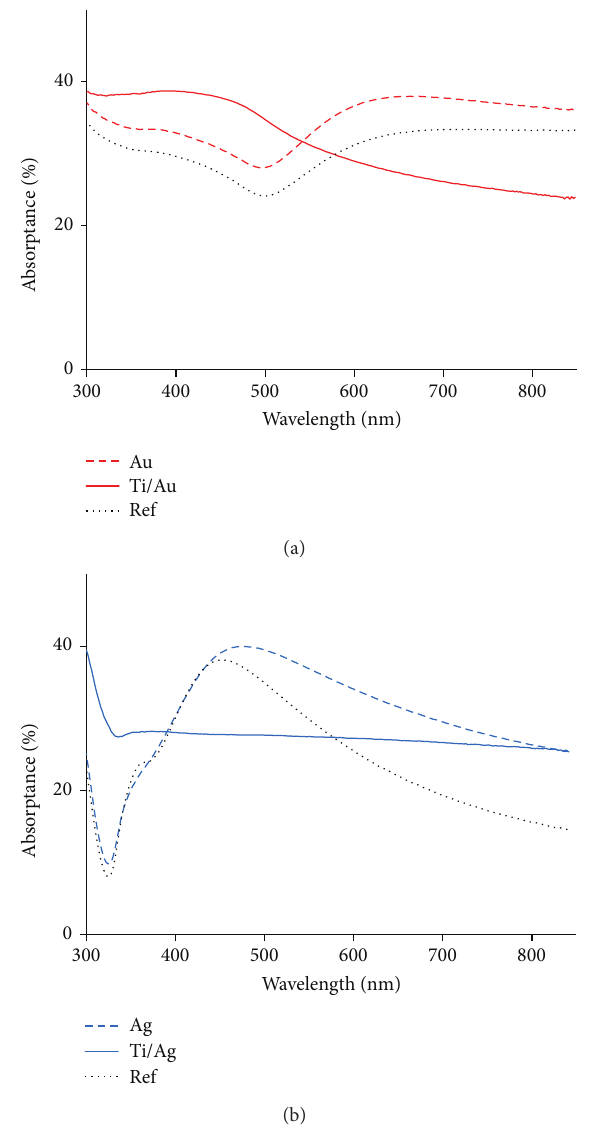
Figure 9: Effect of 2nm thick layer of Ti on the absorptance of 8nm thick nanostructures made of Au (a) and Ag (b) on glass. The deposition angle is 𝛼 = 70 ∘ . The samples were rotated during the deposition. “Ref” stands for an 8nm layer of gold on glass, without Ti.